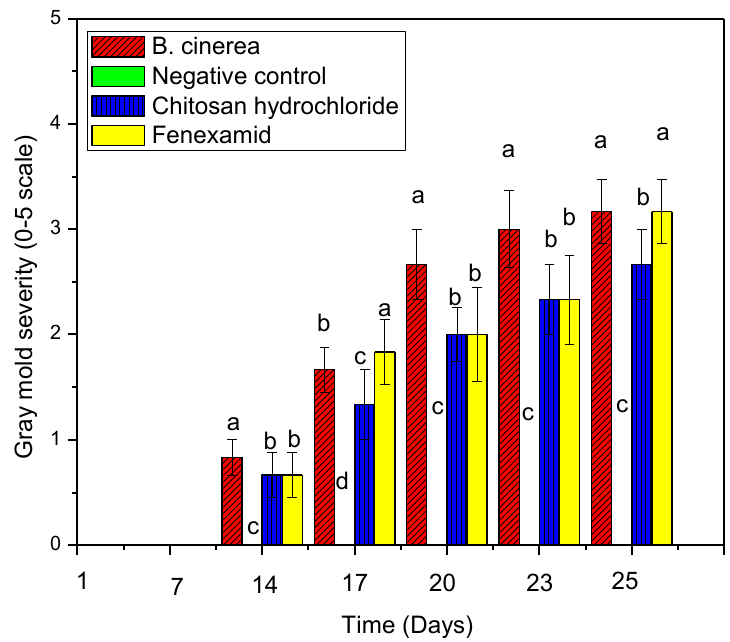
Figure 8. Gray mold severity on kiwifruits artificially inoculated with B. cinerea after treatment with the fungicide fenhexamid or CH. Negative controls were not inoculated. For each evaluation date, columns with different letters are significantly different according to Tukey’s HSD test ( p = 0.01) . Green histograms related to negative controls (only sterile distilled water, SDW) are absent because non-microbial growth was recorded in this thesis. Significant differences among the bars are marked with different letters; if there is no significant difference among the bars they get the same letter.